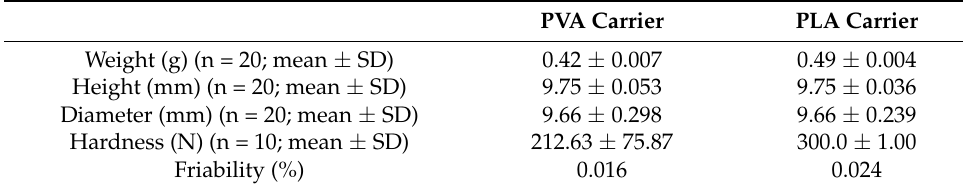
Table 1. Physical characteristics of 3D printed